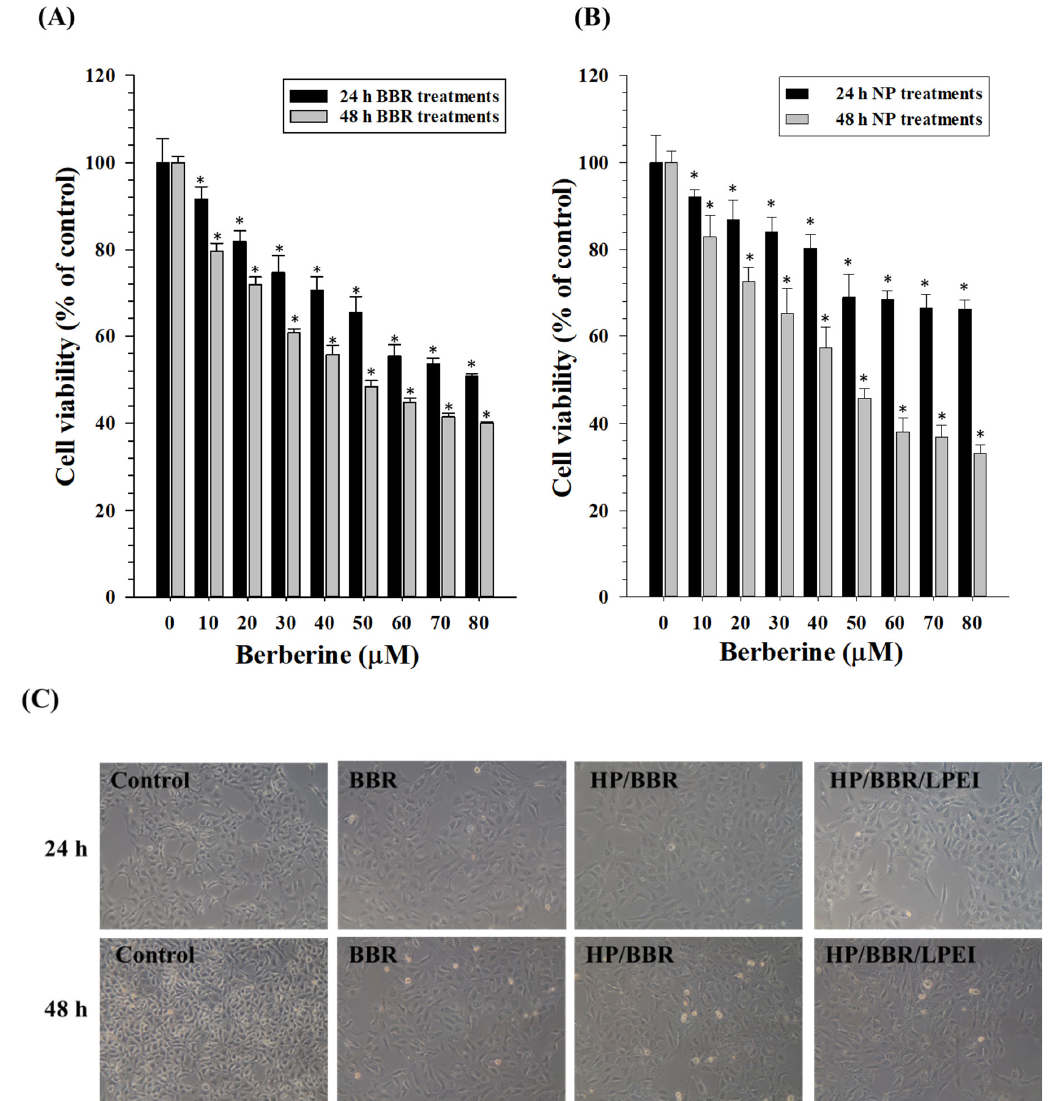
Figure 3. The cell viability and morphology of U-2 OS cells treated with BBR or BBR nanoparticles (HP/BBR or HP/BBR/LPEI nanoparticles). ( A ) U-2 OS cells were treated with different